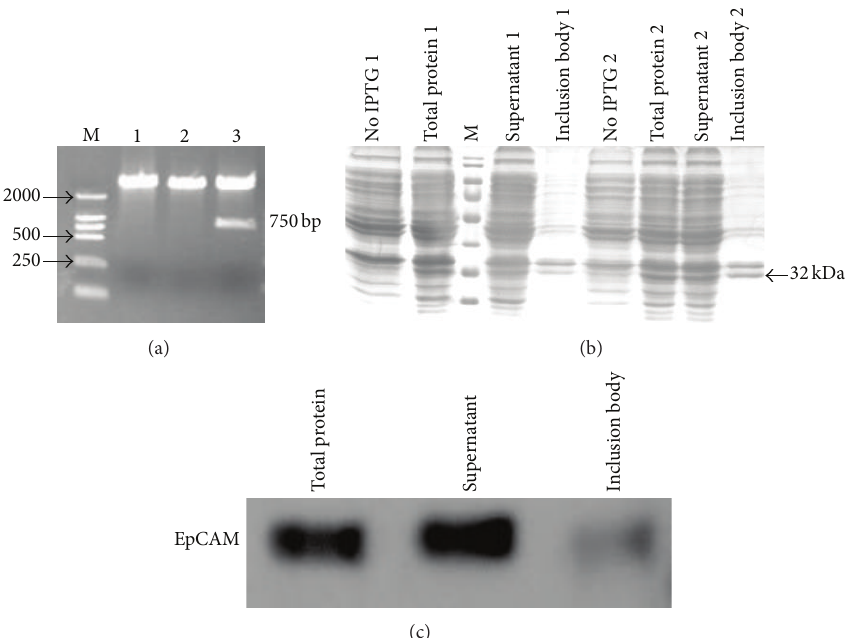
Figure 4: Restriction enzyme analysis, SDS-PAGE, and Western blot of recombinant EpCAM expressed in M15 E. coli cells. (a) The plasmid pQE30-EpCAM was digested with Kpn I and Hind III. Lanes: (M) LD2000 DNA marker; (1–3) digestion products 1 and 2 were negative colonies; 3 was the positive colony. (b) Proteins were separated by 10% SDS-PAGE and visualized by Coomassie Brilliant Blue R250 staining. Two colonies were induced to express protein. (c) Purified HIS-EpCAM was identified by Western blot.